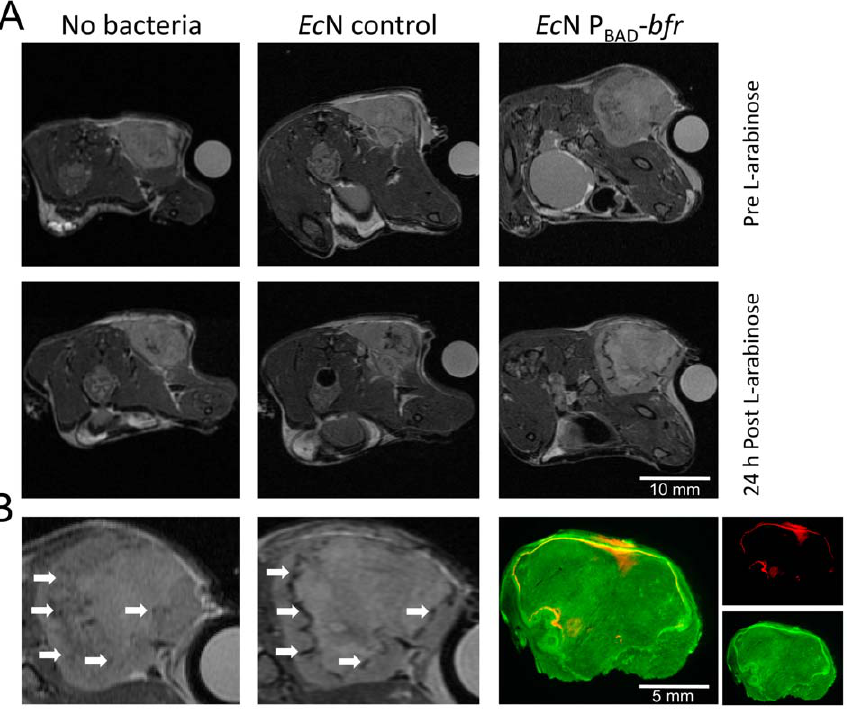
Figure 3. Effects of induced Bfr expression on T2 weighted imaging invivo . A ) Tumor-bearing mice were injected with PBS (no bacteria), an Ec N control strain ( Ec N control), or Ec N expressing Bfr upon induction with L-arabinose ( Ec N P BAD - bfr ). Mice were imaged just before, and 24 h after injection of L-arabionse. Only in the Bfr overproducing Ec N were distinct dark regions visible 24 h after the inducer was injected. B ) Enlarged Ec N P BAD - bfr colonized tumor before and 24 h after L-arabinose injection. Arrows point to the dark rim around the necrotic center of the tumor corresponding to immunofluorescent staining of Ec N (red) in sections of (a different) tumor (right panels). Actin was stained green.